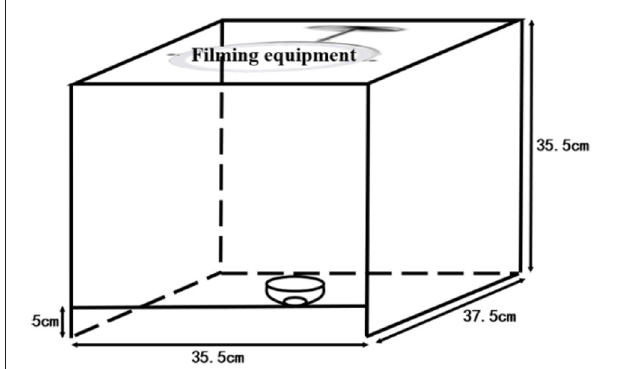
FIGURE 1 | The urine image